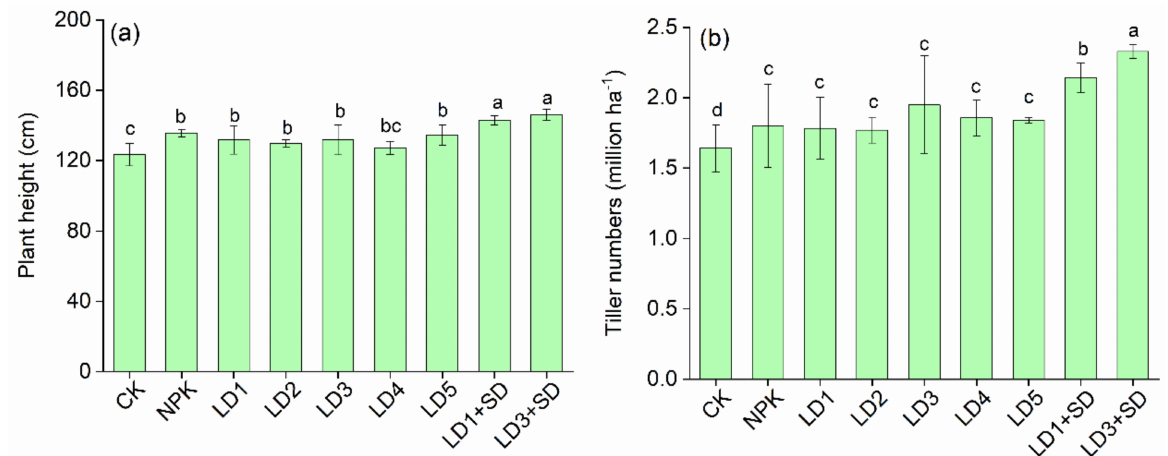
Figure 3. Rice plant height ( a ) and tiller numbers ( b ) under different treatments, respectively. The values are means with standard error bars. Different letters above the bars indicate significant differences at the 5%